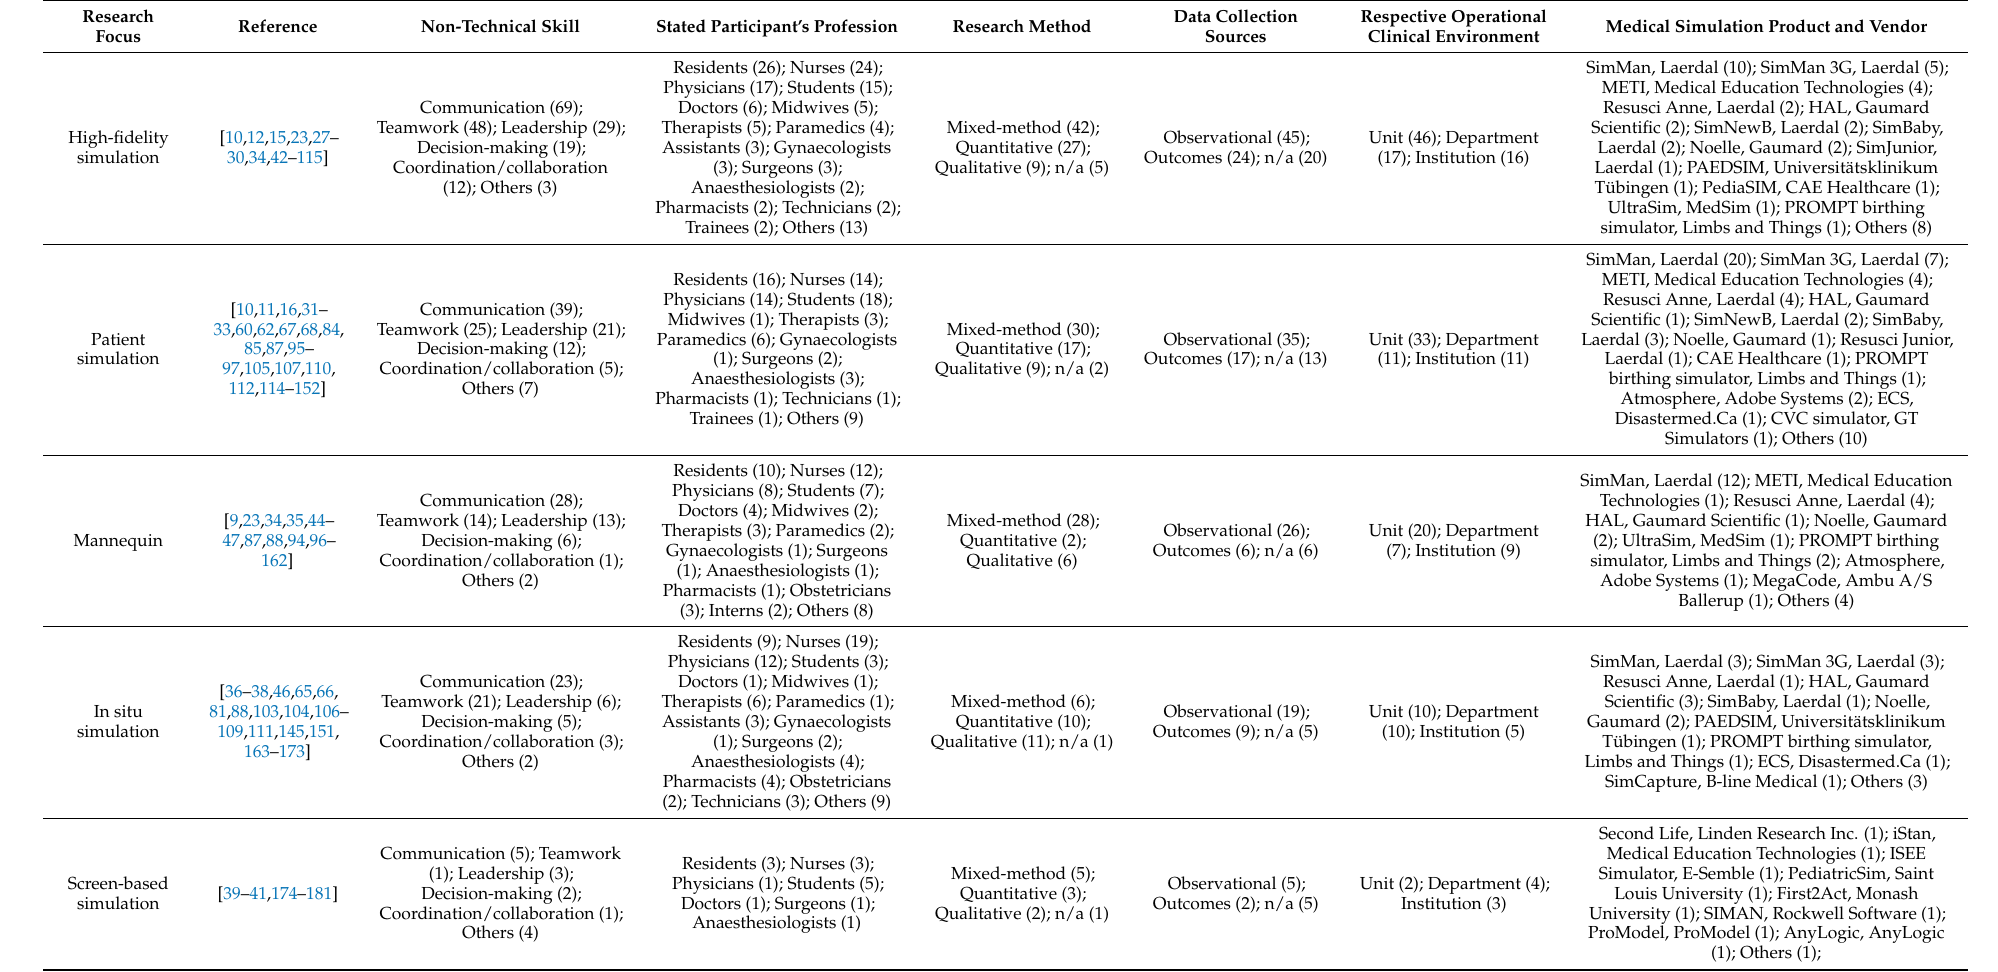
Table 1. Classification of